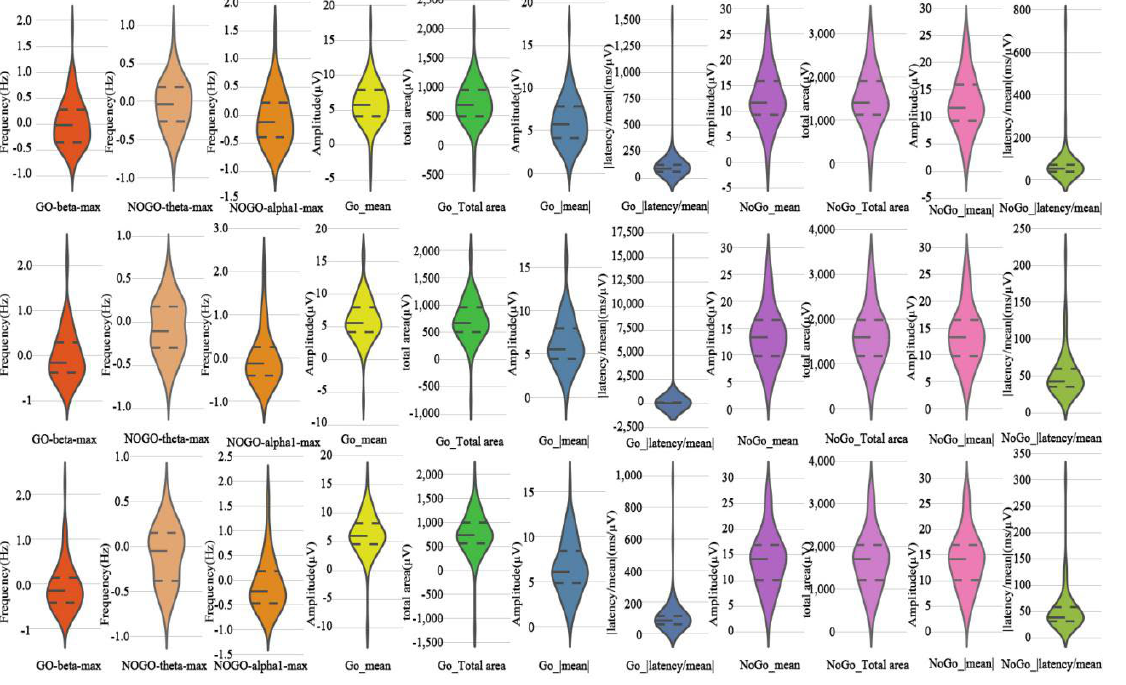
Figure 6. Violin diagrams showed the distribution of extracted features. GO-beta-max = Maximum power value of beta band during Go trials; NoGo-theta-max = maximum power value of theta band during No-Go trials; NOGO-alpha1-max = maximum power value of alpha1 band during No-Go trials; Go_mean = average amplitude of SP components during Go trials; Go_Total area = total area of SP components during Go trials; Go_|mean| = absolute value of the mean amplitude of SP component during Go trials; Go_|latency/mean| = absolute value of the ratio between latency and mean amplitude of SP components during Go trials; NoGo_mean = average amplitude of SP components during No-Go trials; NoGo_Total area = total area of SP components during No-Go trials; NoGo_|mean| = absolute value of the mean amplitude of SP component during No-Go trials; NoGo_|latency/mean| = absolute value of the ratio between latency and mean amplitude of SP components during No-Go trials. Table 7. Precision, sensitivity, and specificity values achieved for ERPs and EROs by the SVM, LR, and DT algorithms for the Elman neural network.